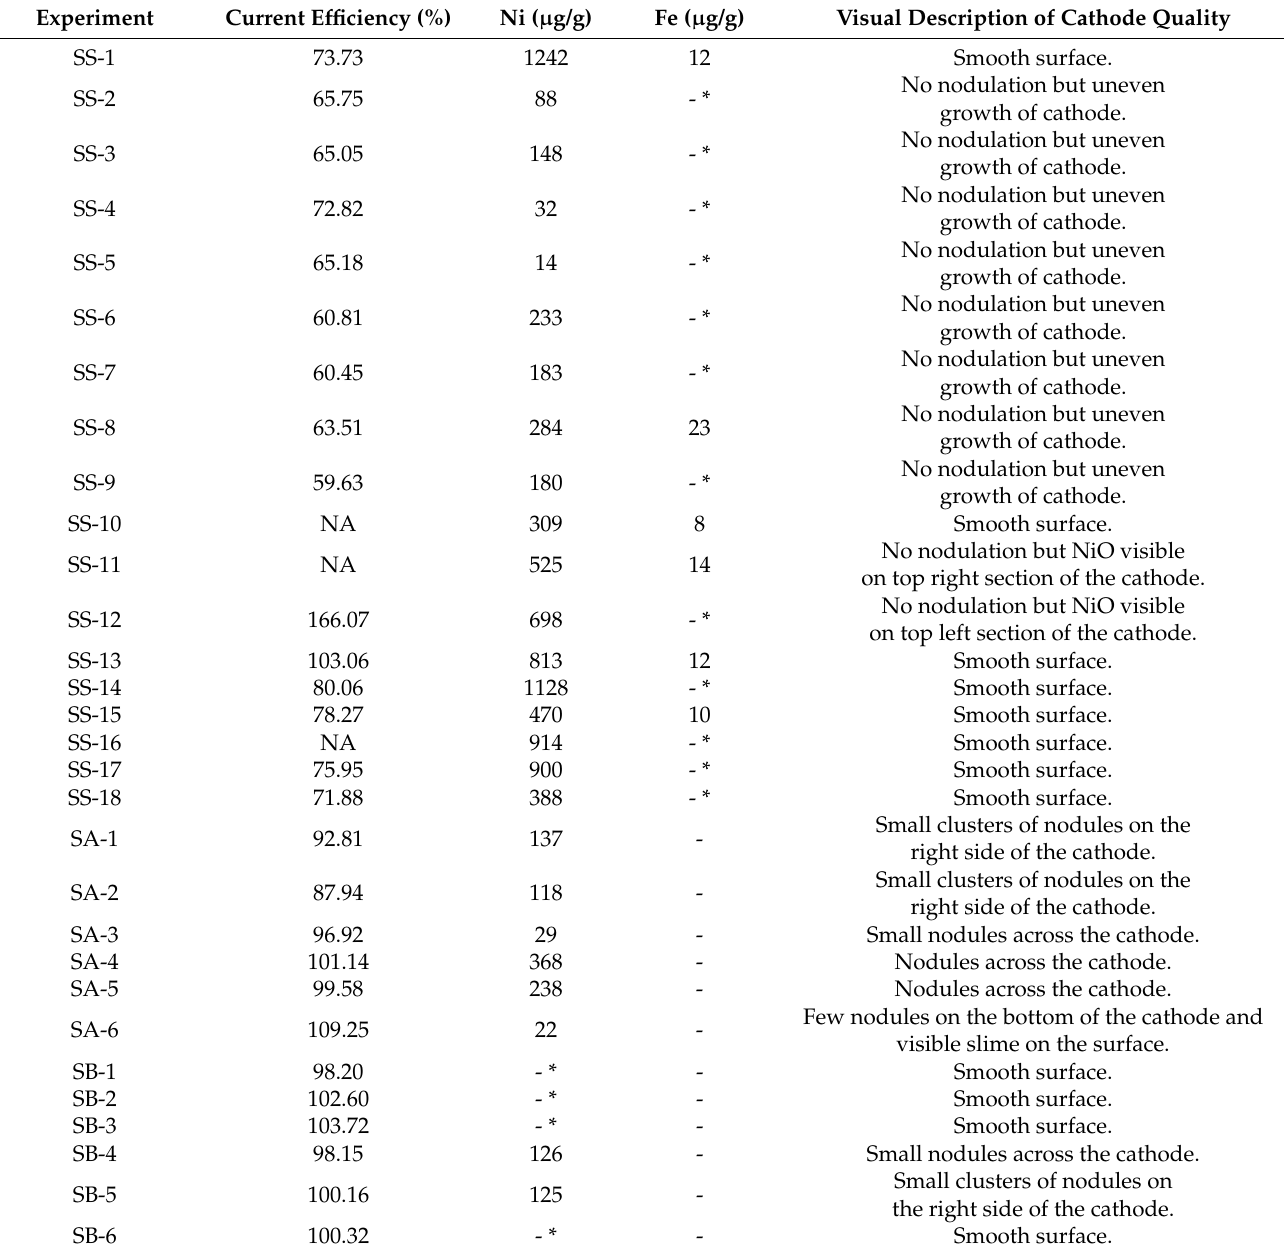
Table 5. Summary of the particle entrapment experiments. Ni and Fe values are concentrations in the solid cathode based on the total dissolution to aqua regia and analysis by AAS. * Solution analysis results below the detection limit (<0.2 µ g/mL). Fe analysis was not performed for the SA and